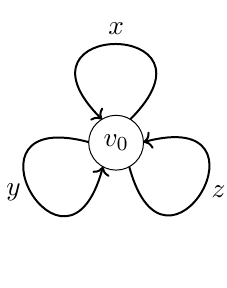
Figure 50. Quiver corresponding to C 3 .